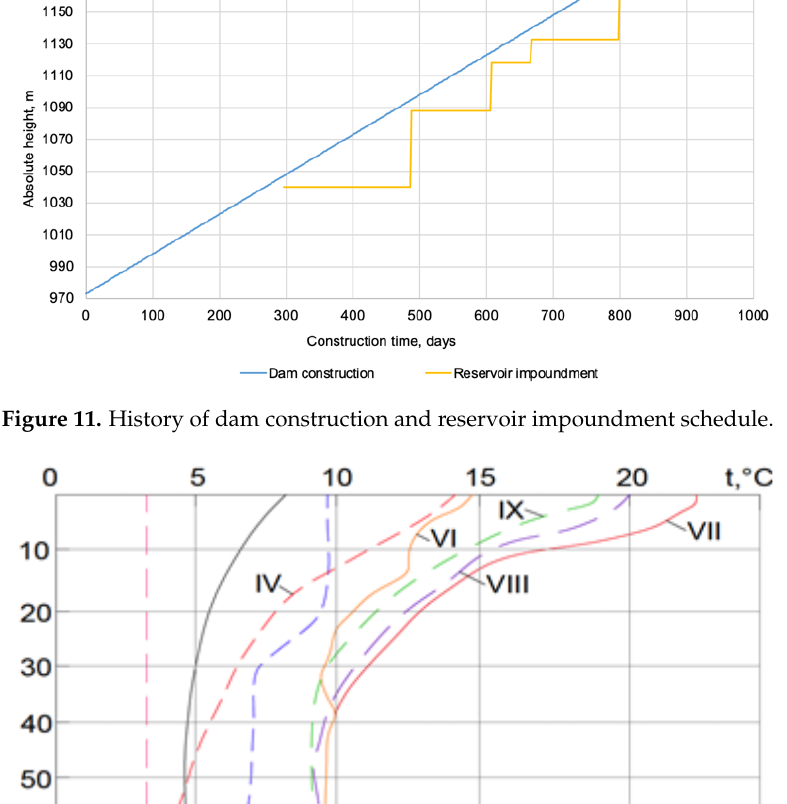
Figure 12. Diagram of reservoir water temperature variation by depth, by month.